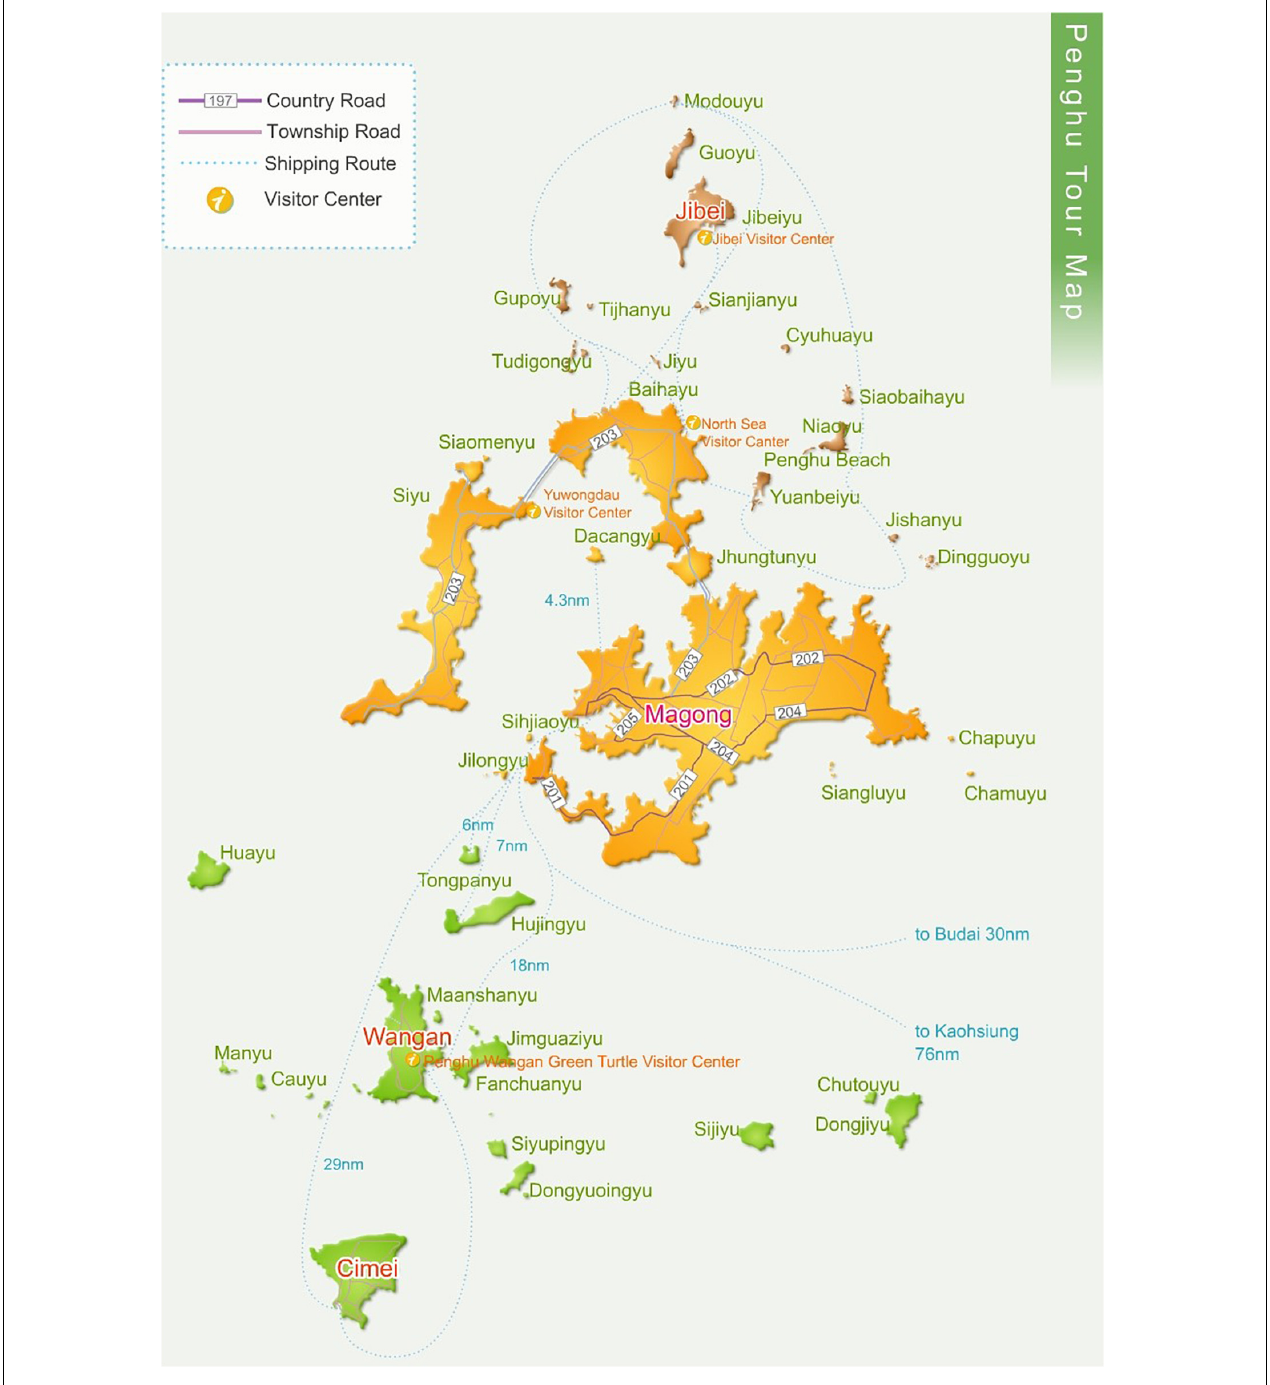
FIGURE 2 | The map of the Penghu National Scenic Area.